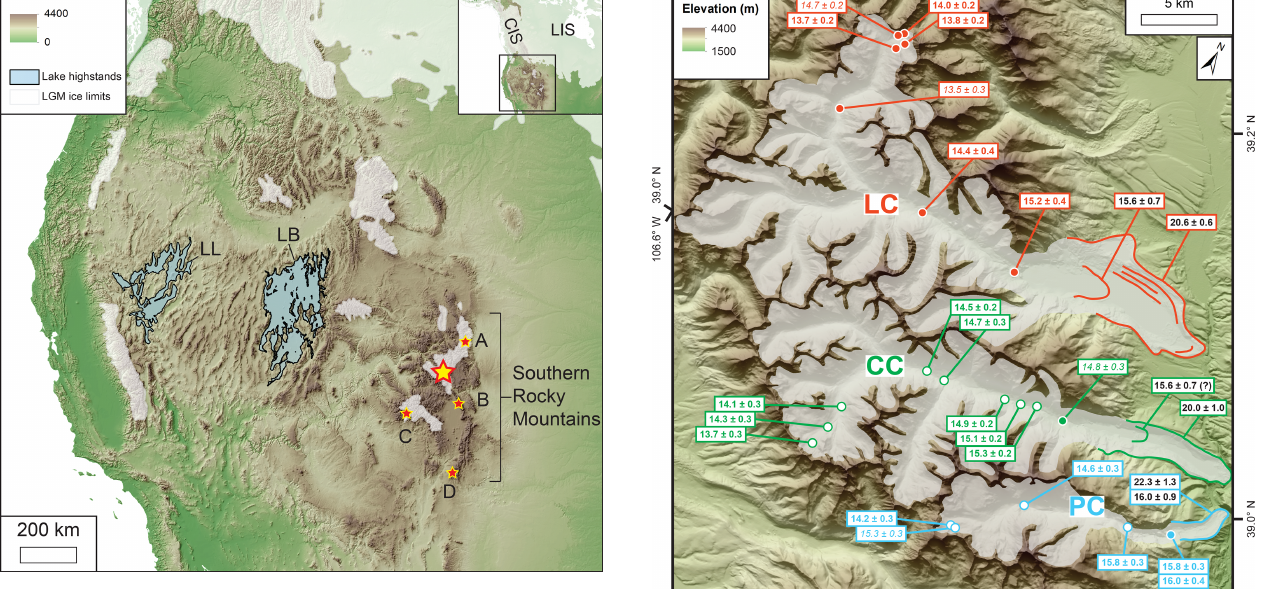
Figure 1. Key moraine chronologies from the southern Rocky Mountains and locations of glaciation centers and large pluvial lakes in the western US following the Last Glacial Maximum (LGM). LL: Lake Lahontan, LB: Lake Bonneville, A: Colorado Front Range, B: Sangre de Cristo Mountains, C: San Juan Moun- tains, and D: Winsor Creek valley, New Mexico. The largest star corresponds to our field site in the Sawatch Range. LGM ice limits are from Dalton et al. (2020). The inset is of the western portion of North America. CIS: Cordilleran Ice Sheet, LIS: Laurentide Ice Sheet.